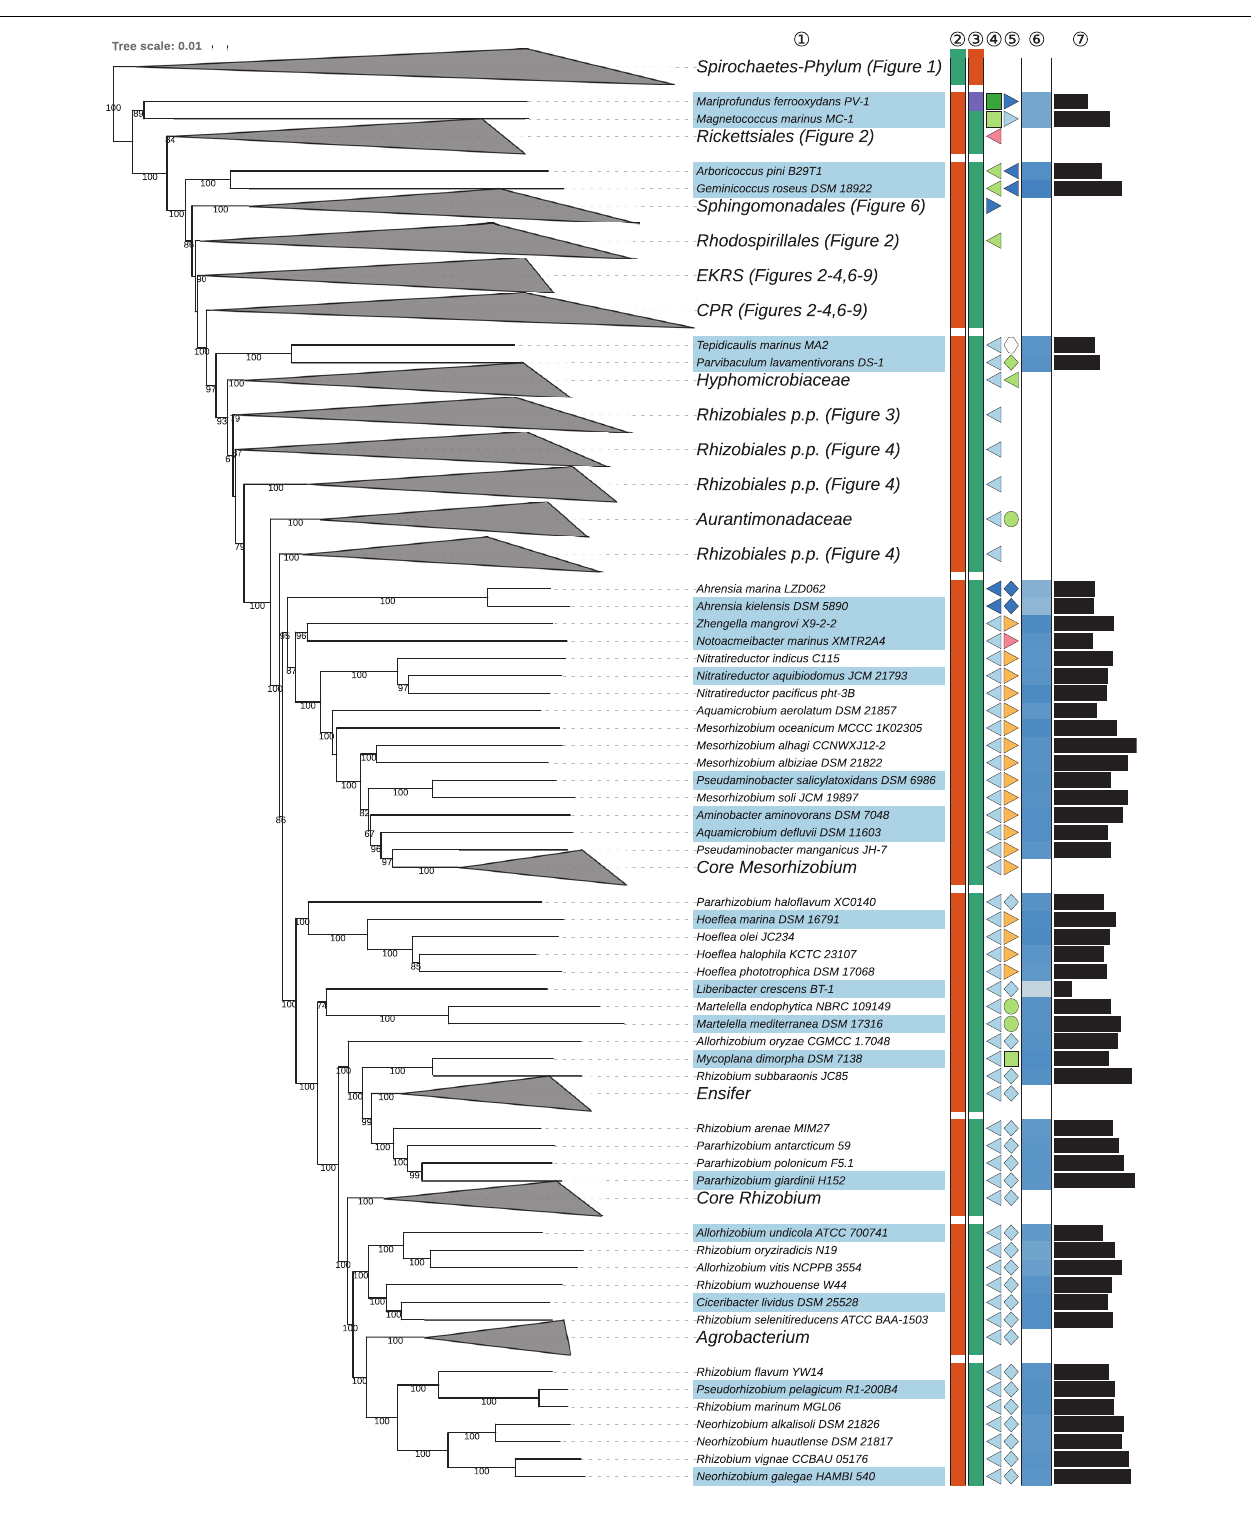
FIGURE 5 | Fourth part of the GBDP tree shown in Figure 1 , focussing on parts of Rhizobiales ( Hyphomicrobiales ). The clade labeled EKRS comprises the orders Emcibacterales, Kordiimonadales, Rhodothalassiales and Sneathiellales , whereas CPR denotes the clade including the orders Caulobacterales , Parvularculales, and Rhodobacterales , details for which are shown in the subsequent figures. Tip labels with light-blue background indicate type species of genera, colors and symbols to the right of the tips indicate, from left to right, phylum, class, order, and family; for details and abbreviations see Figure 1 . The blue color gradient indicates the G+C content as calculated from the genome sequences, followed by black bars indicating the (approximate) genome size in base pairs.